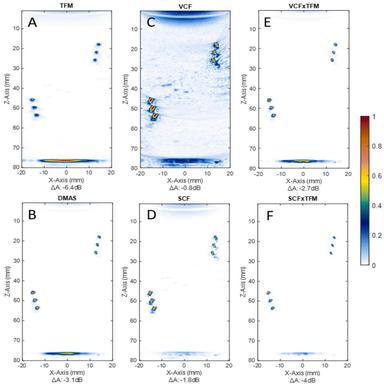
AWS resolution block imaging using: A) the standard TFM algorithm – Delay And Sum; B) Delay Multiply And Sum; C) Vector Coherence Factor imaging; D) Sign Coherence Factor imaging; E) TFM imaging weigthed by Vector Coherence Factor; and F) TFM imaging weigthed by Sign Coherence Factor. ΔA refers to the difference of maximum amplitude between SDH located at mm and mm depth.